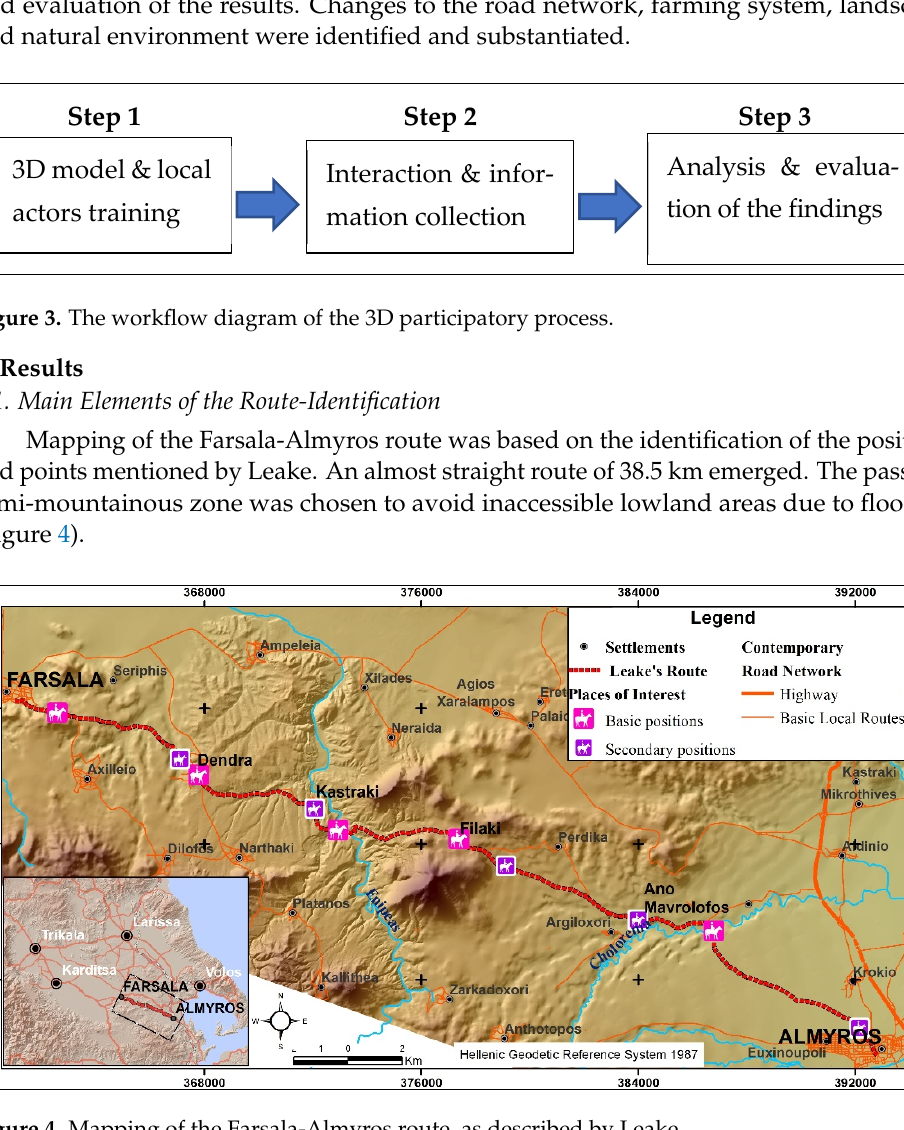
Figure 4. Mapping of the Farsala-Almyros route, as described by Leake.